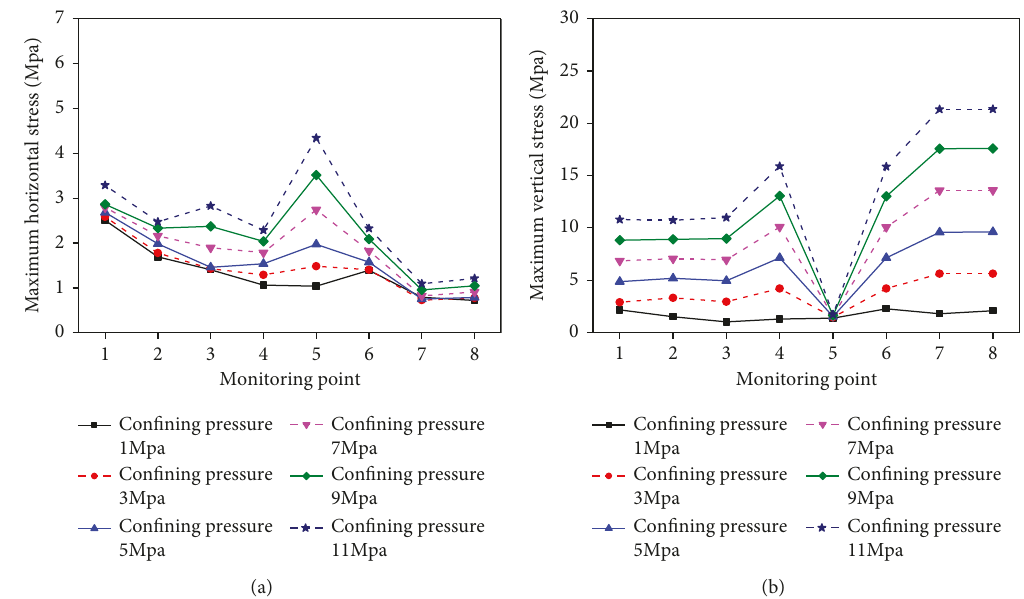
Figure 11: Surrounding rock stresses of the roadway under different confining pressures. (a) Horizontal direction. (b) Vertical direction.